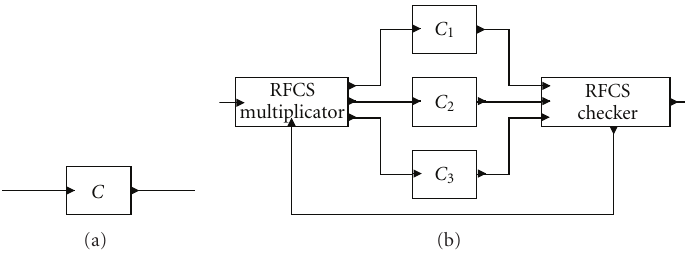
Figure 12: RFCS adaptation pattern applied at KPN